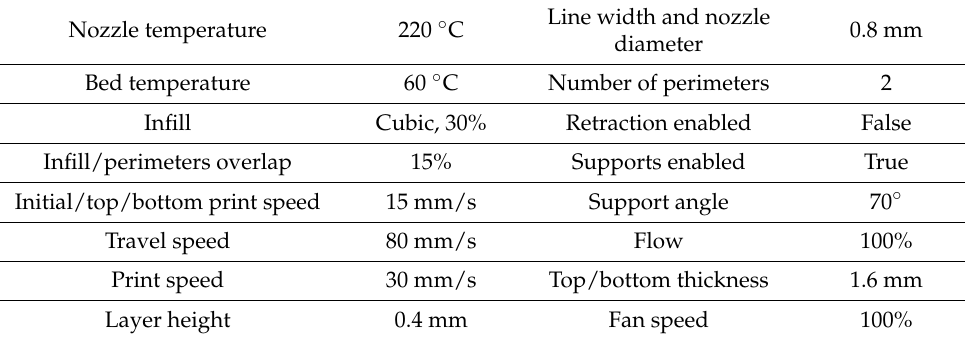
Table 2. Process Table 2. Process parameters.